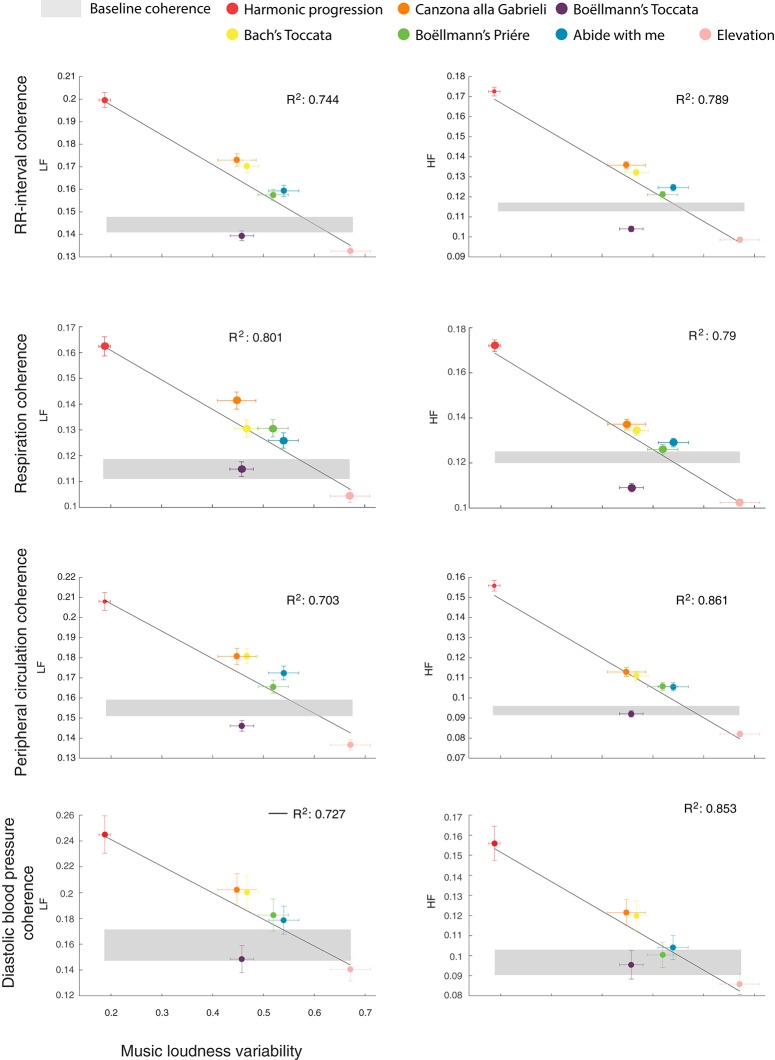
Changes in group synchronization heavily depend on low-level auditory feature. Each dot represents one of the seven music excerpts, plotted as a function of group synchronization (y axis), averaged across musicians and non-musicians, and loudness variability index (x axis). Vertical error bars represent variability in synchronization across different individuals and days. Horizontal error bars represent variability in the loudness variability index across different performances of the same excerpt. The shaded gray area represents the average group synchronization during the initial resting baseline (mean ± SE). Dots below and above the gray shaded area indicate decreased and increased group synchronization compared to baseline, respectively, (see Table 2 for a statistical account of the comparison with baseline). It can be seen that greater autonomic synchronization is achieved for music excerpts with lower loudness variability index.